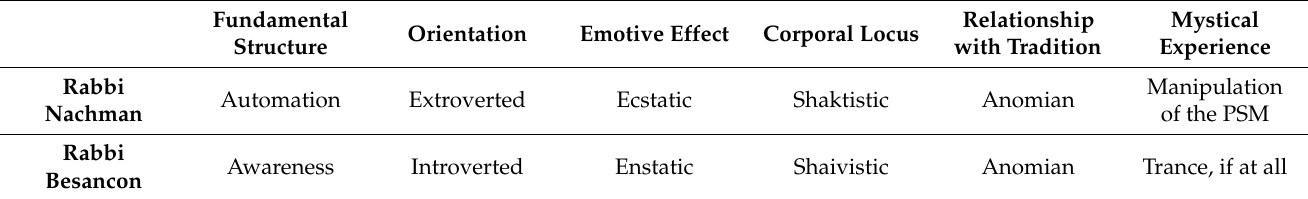
Table 2. Phenomenological Comparison of Meditative Technique and Mystical Experience in Nach- man and